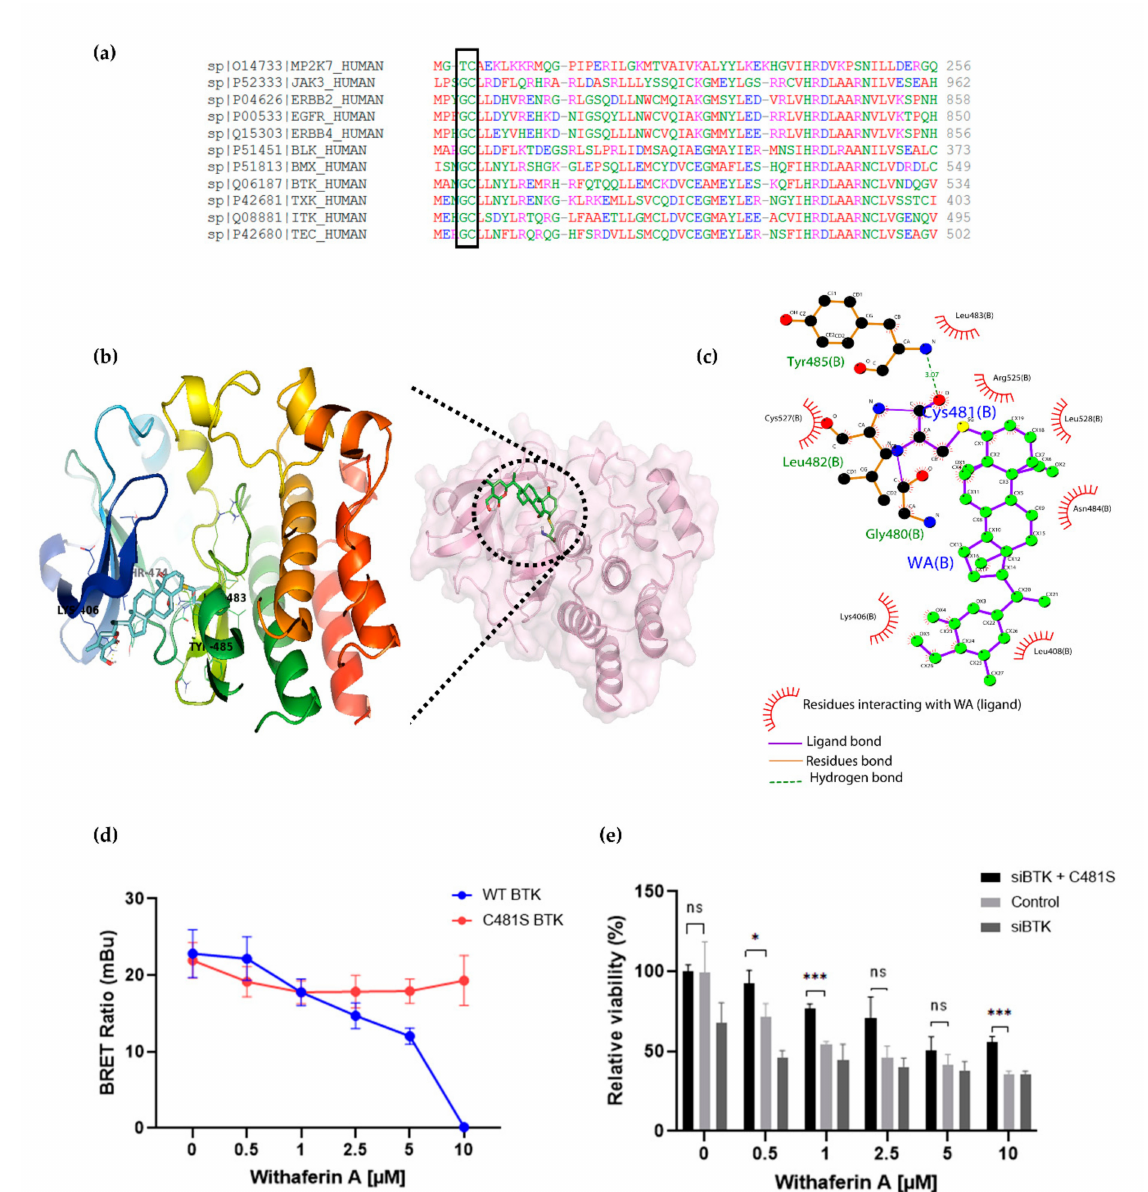
Figure 5. ( a ) Multiple sequence alignment of Hinge 6 domain-type kinases. The conserved GC-motif between different orthologs is indicated. Alignment was performed with Clustal Omega (https://www.ebi.ac.uk/Tools/msa/clustalo/ accessed on 30 November 2020). ( b ) Crystal structure of BTK (PBD id: 6TFP) in complex with WA (PubChem CID: 26537) covalently bound to Cys481. ( c ) Interaction between WA and BTK structure visualized using Ligplot [74], showing the covalent bond formation of the C4-OH group of WA with the SH group of Cys481 from BTK. ( d ) Inhibition of wild-type (WT) BTK and mutated (C481S) BTK by WA in HEK-293 cells. Data are plotted as mean ± s.d., n = 3 biologically independent replicates. ( e ) Relative viability of MM1R cells treated for 24 h with increasing concentrations of WA, upon BTK silencing (siBTK) in presence or absence of C481S BTK overexpression. Data are plotted as mean ± s.d., n = 3 biologically independent replicates (ns = p > 0.05, * p = 0.0309, *** p < 0.0001,